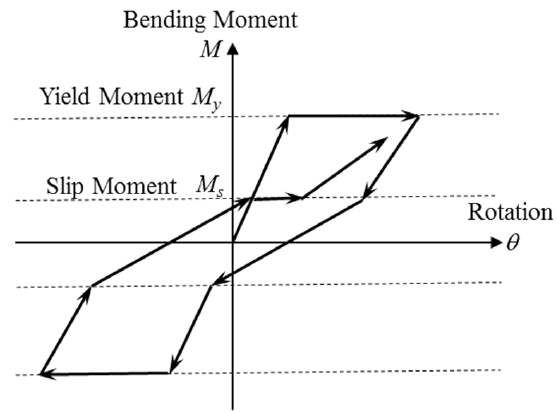
Figure 8. Equivalent sti ff ness and damping ratio.